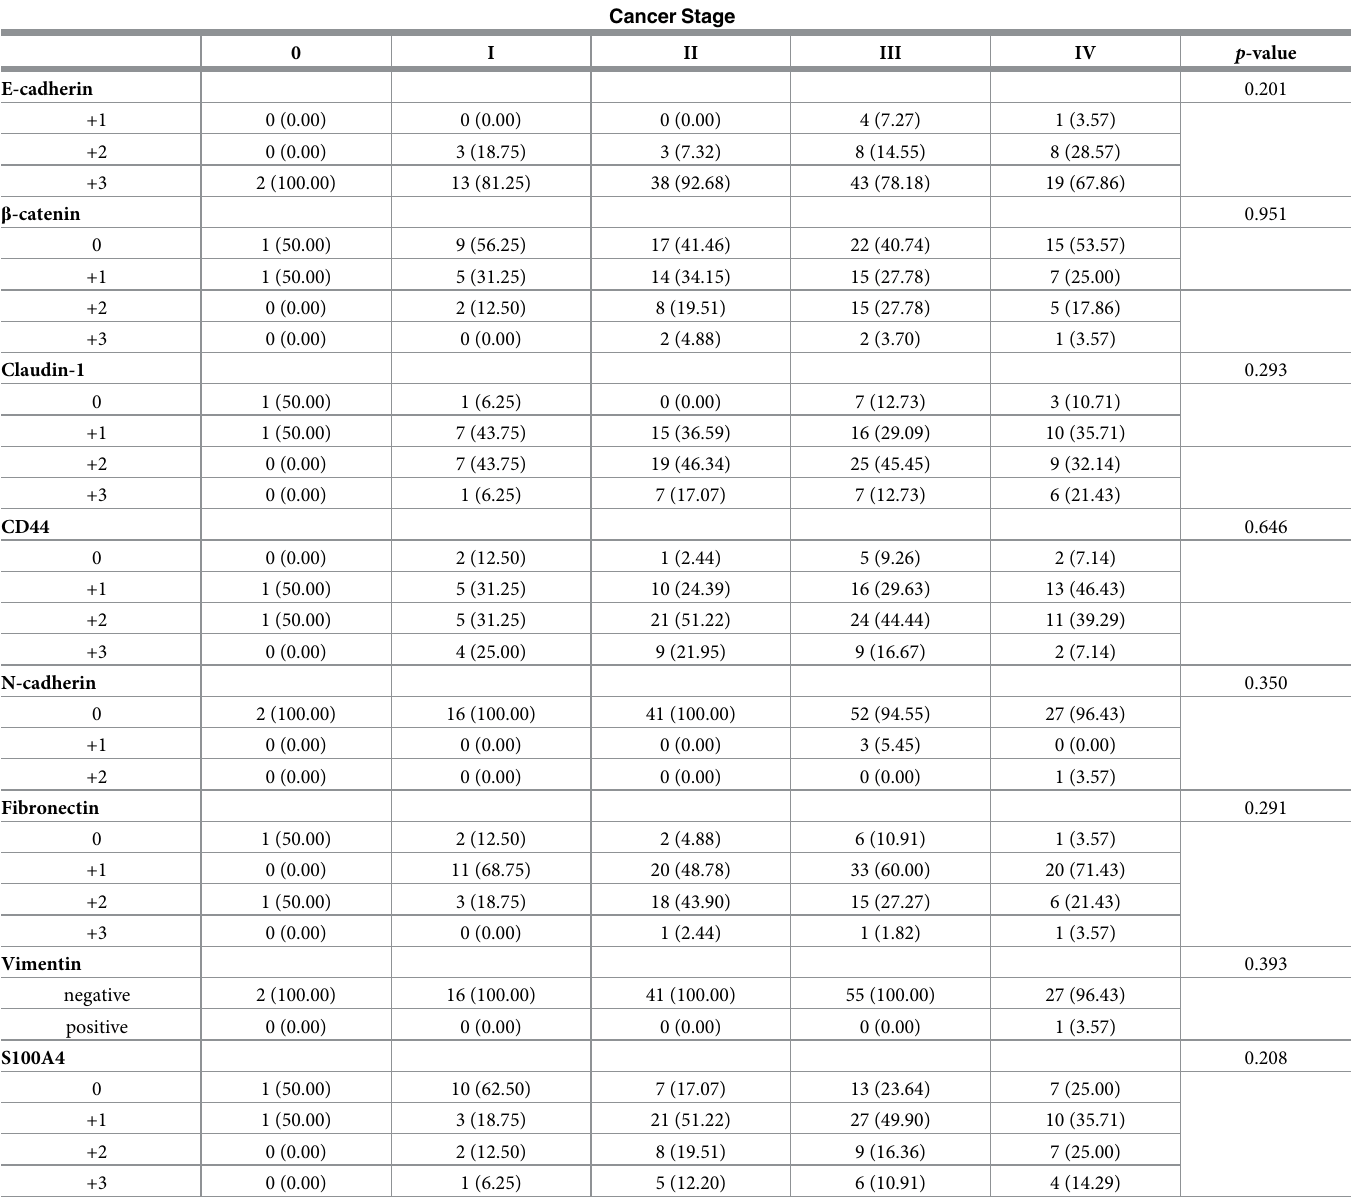
Table 4. IHC expression of EMT-related markers vs . cancer stages classified into 0 to